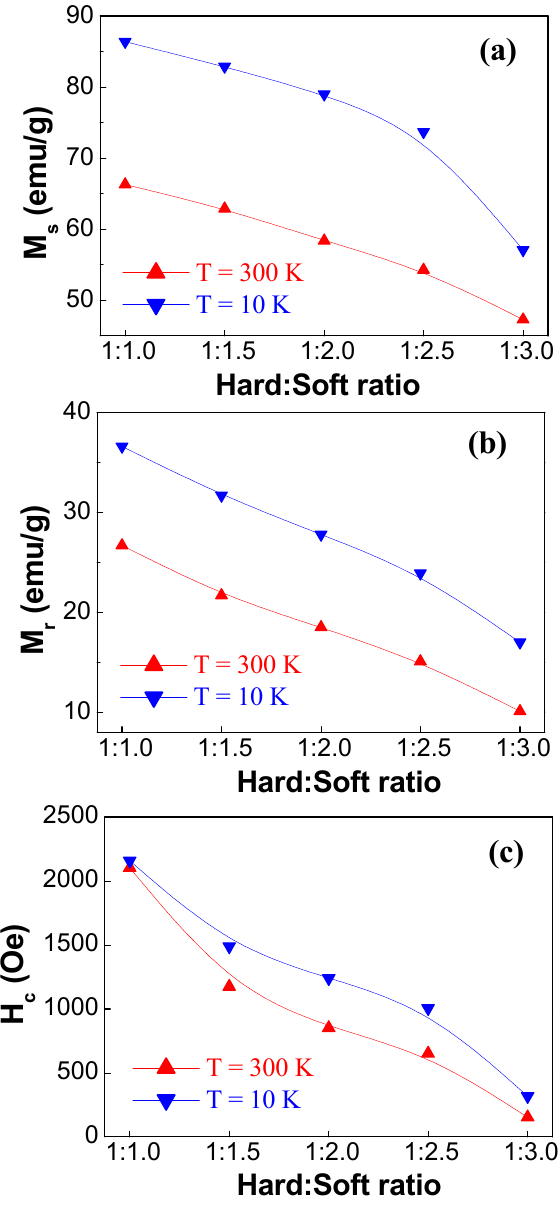
Figure 8. Variations in ( a ) saturation magnetization (M s ), ( b ) remnant magnetization (M r ), and ( c ) coercivity (H c ) at both 300 and 10 K for various produced hard/soft ferrite SrBaSmFe/(NiZnFe) x NCs (1.0 ≤ x ≤ 3.0) products.